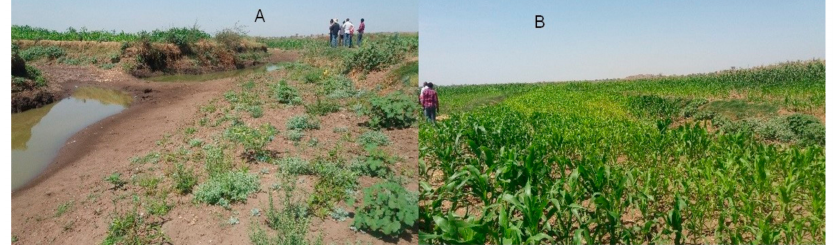
Figure 5. Lower Ribb River reach. ( A ) the point where the river loses its channel; ( B ) maize plantation using residual moisture along the river channel downstream of location